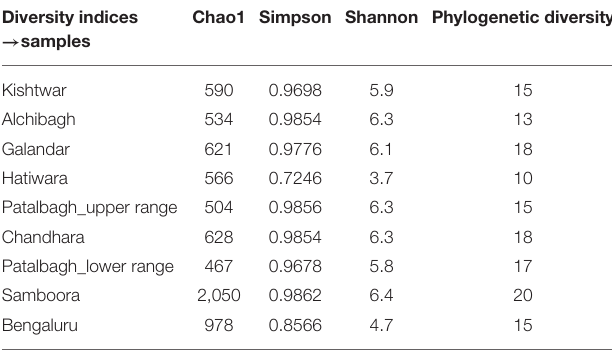
TABLE 3 | Diversity indices were the maximum in Samboora representing maximum bacteria diversity and richness in rhizosphere of saffron growing in Samboora as compared to other